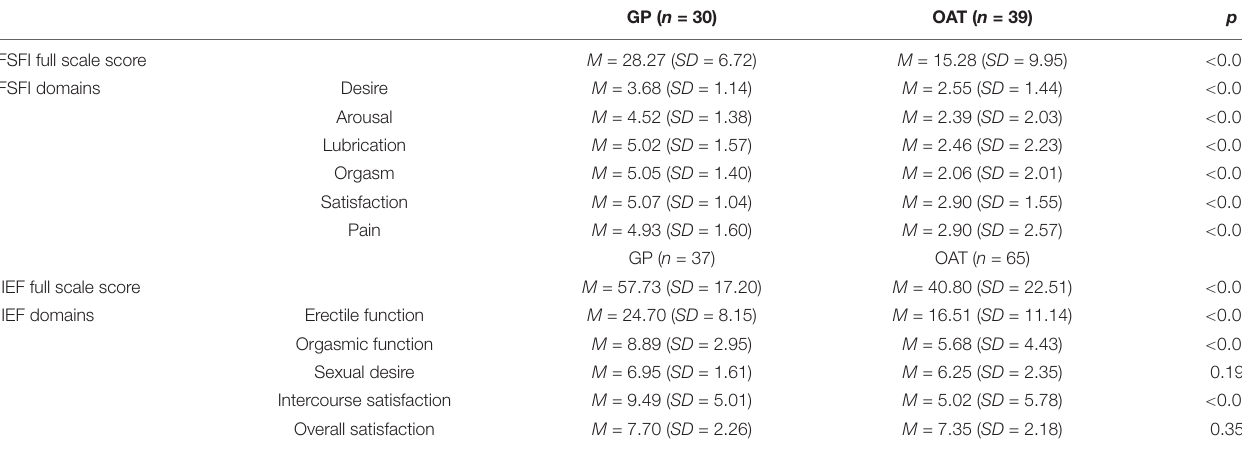
TABLE 2 | Sexual functioning in GP and OAT patients.